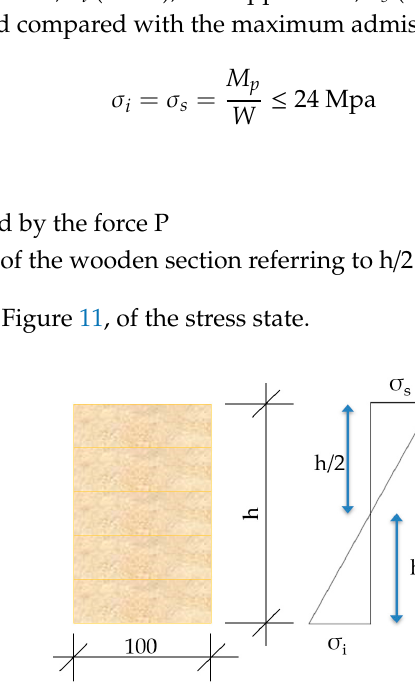
Figure 11. Stress state of an isolated joist.